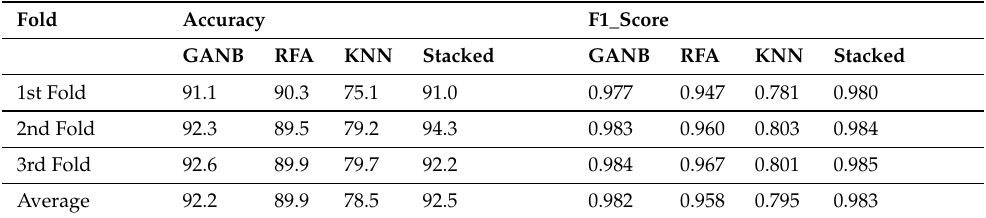
Table 3. Accuracy and F1_score for K fold cross